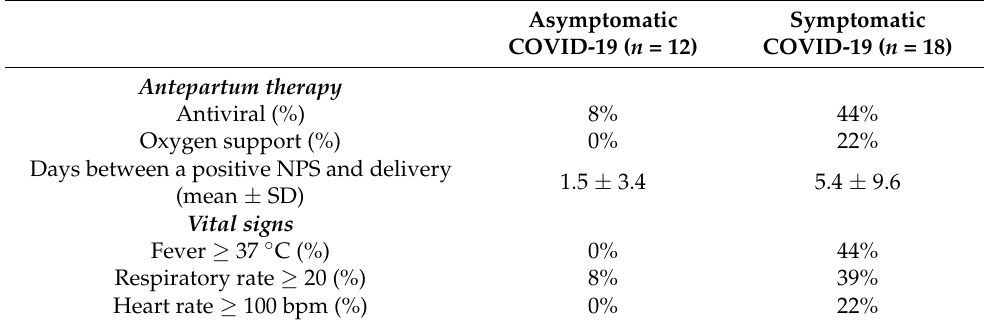
Table 2. Therapy and clinical history of the SARS-CoV-2-positive patients. NPS: nasopharyngeal swab. SD: standard